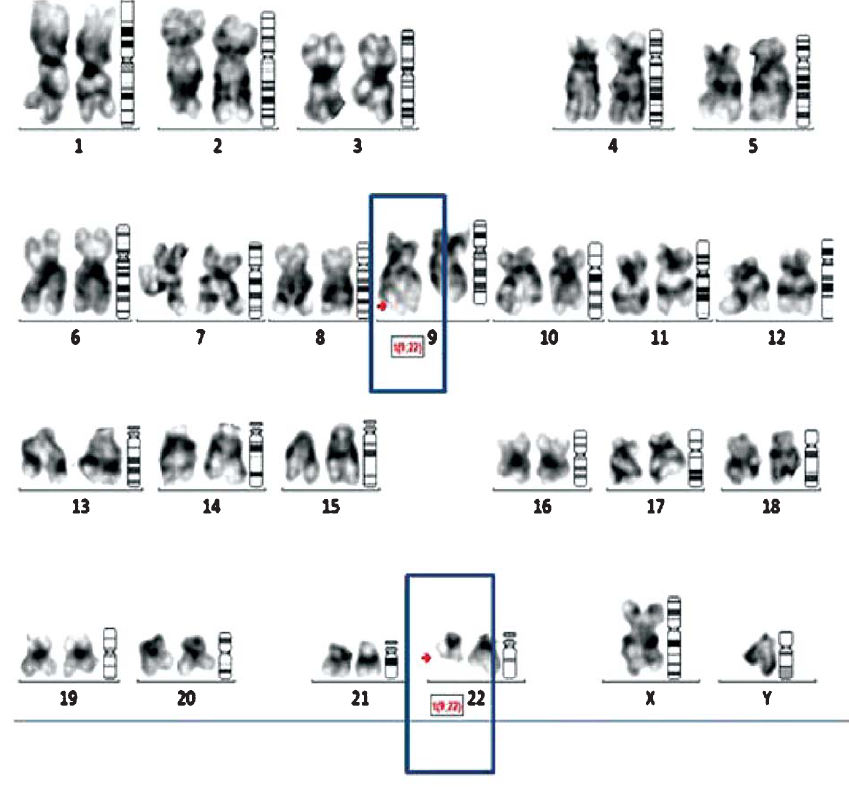
Fig. 1. Cytogenetic analysis showing chromosomal translocation [t(9;22)] in chromosome 9 and 22 (black